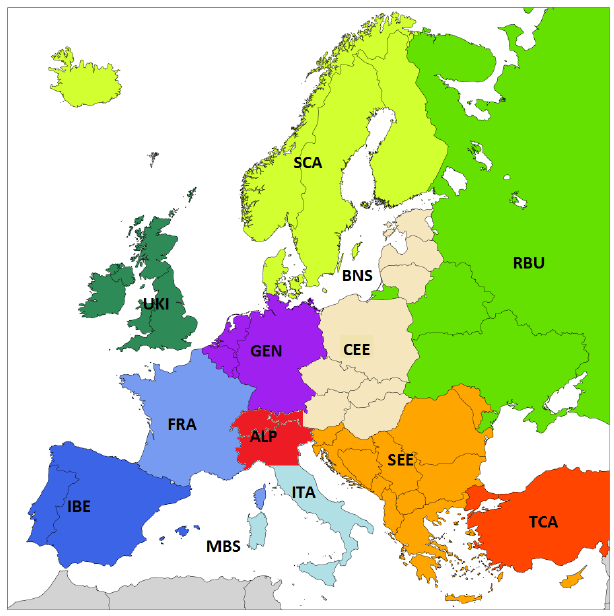
Figure 1. Tagged European source